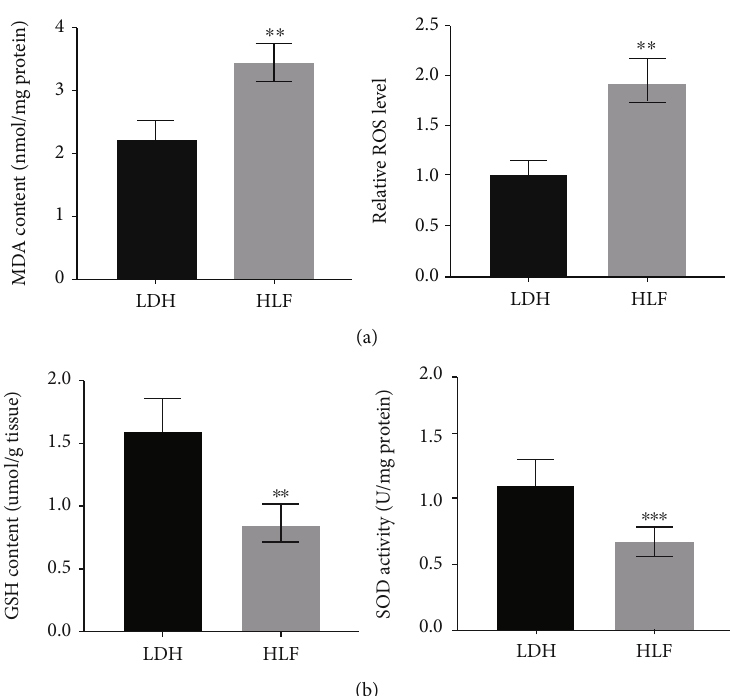
Figure 2: Oxidative stress was upregulated in LF tissues from HLF patients. (a) The ROS levels and malondialdehyde (MDA) were higher in the HLF group compared with the LDH group. ( n = 27 ). ∗∗ p < 0 : 01 . (b) The glutathione (GSH) content, and superoxide dismutase (SOD) activity were decreased in the HLF group compared with the LDH group ( n = 27 ). ∗∗ p < 0 : 01 , ∗∗∗ p < 0 : 001